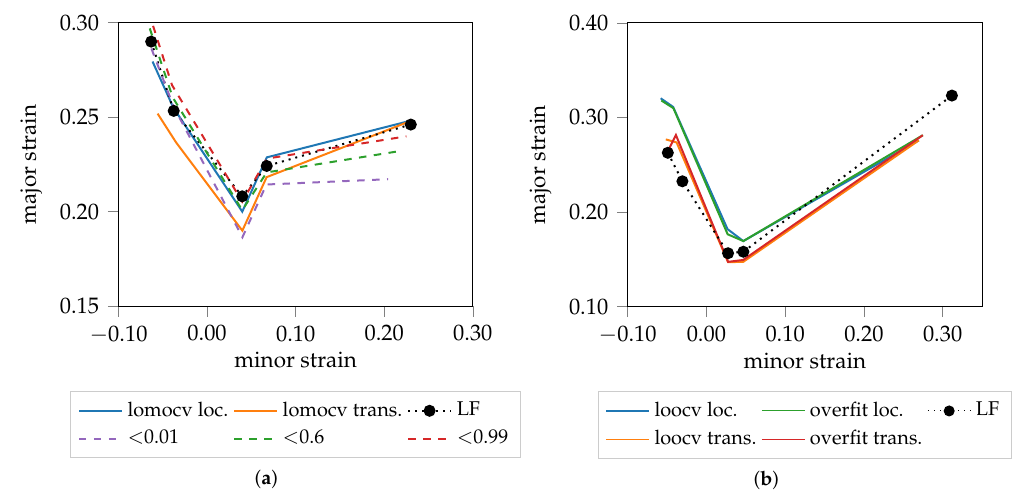
Figure 9. Comparison with state of the art for DP800 ( a ) and AA5182 ( b ).